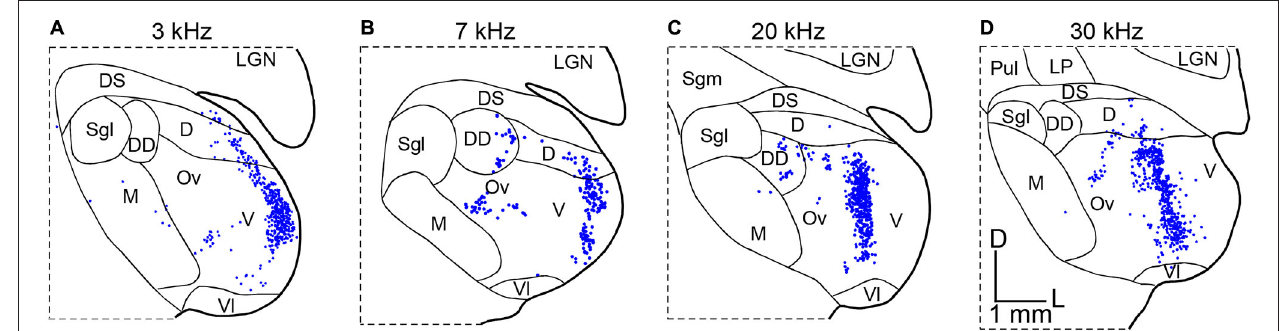
injections in the 30 kHz CF lamina of A1. Modified from Lee et al. (2004b). D: dorsal nucleus of the MGB, DD: deep dorsal nucleus of the MGB, DS: dorsal superficial nucleus of the MGB, LGN: lateral geniculate nucleus, LP: lateroposterior thalamic nucleus, M: medial division of the MGB, Ov: pars ovoidea of the MGB, Pul: pulvinar, Sgl: suprageniculate nucleus, lateral part, Sgm: suprageniculate nucleus, medial part, V: ventral division of the MGB, Vl: ventrolateral nucleus of the MGB, D: dorsal, L: lateral. The scale bar in (D) is applied to all